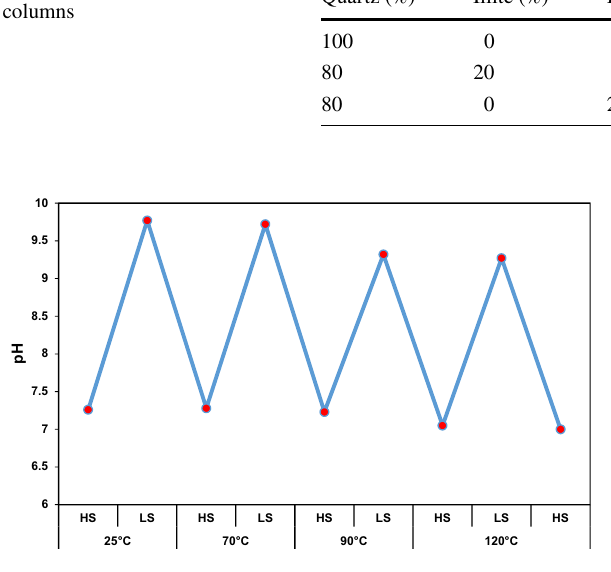
Table 2 Description of the columns